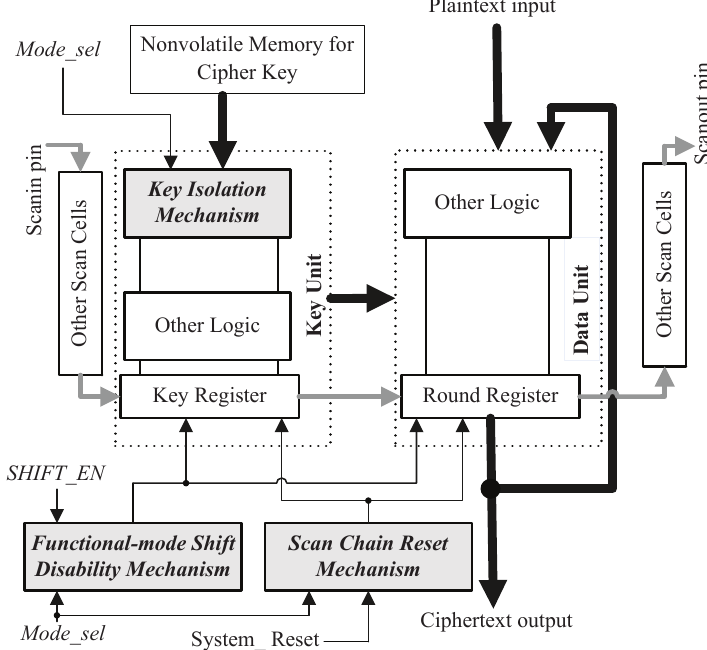
Figure 3. Proposed secure scan test architecture.